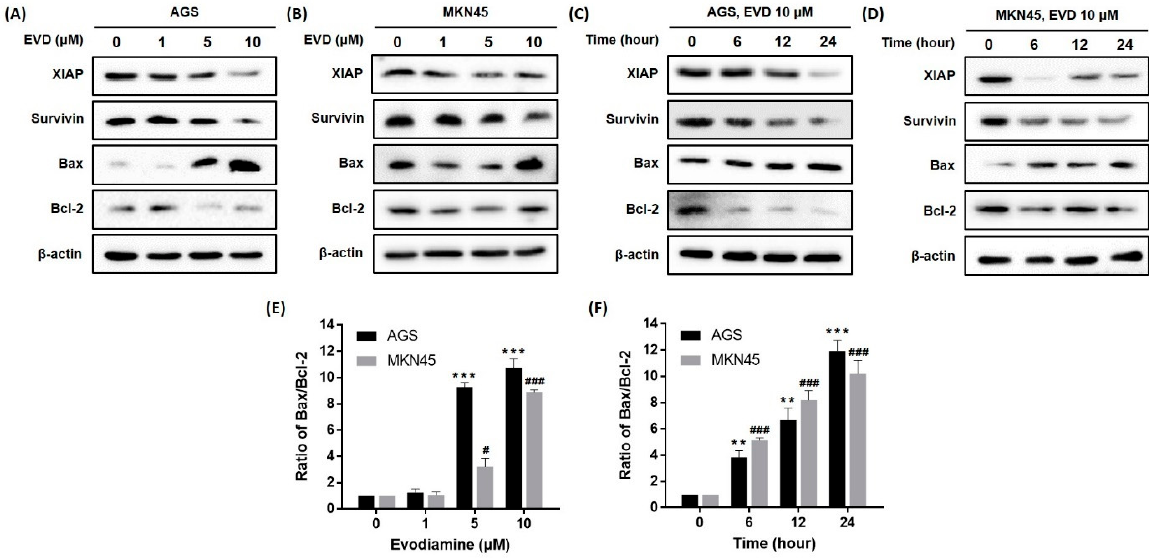
Figure 4. Effect of evodiamine on the expression of the anti- and pro-apoptotic molecules in AGS and MKN45 cells. Indicated doses of evodiamine (0, 1, 5, and 10 μ M) for 24 h were applied to ( A ) AGS and ( B ) MKN45 cells. A total of 10 μ M evodiamine for the indicated time periods (0, 6, 12, 24 h) was applied to ( C ) AGS and ( D ) MKN45 cells. The cell lysates were subjected to Western blot to evaluate the levels of XIAP, survivin, Bax, and Bcl-2. β -actin was used as an internal control. ( E , F ) The intensity of Bax and Bcl-2 was normalized to β -actin and the ratio was calculated. Data are presented as the mean ± SEM of three independent experiments and analyzed by a Student’s t -test. ** p < 0.01 and *** p < 0.001 vs. the non-treated control in AGS cells; # p < 0.05 and ### p < 0.001 vs. the non-treated control in MKN45 cells. EVD,